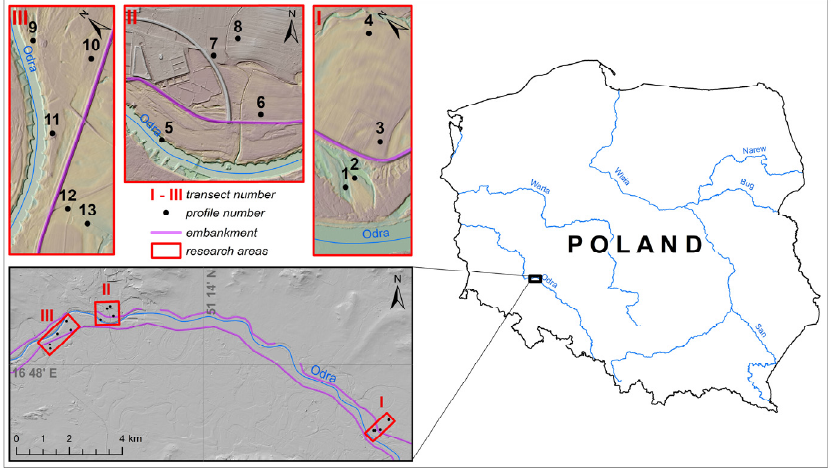
Figure 1. Study area and situation of soil profiles.